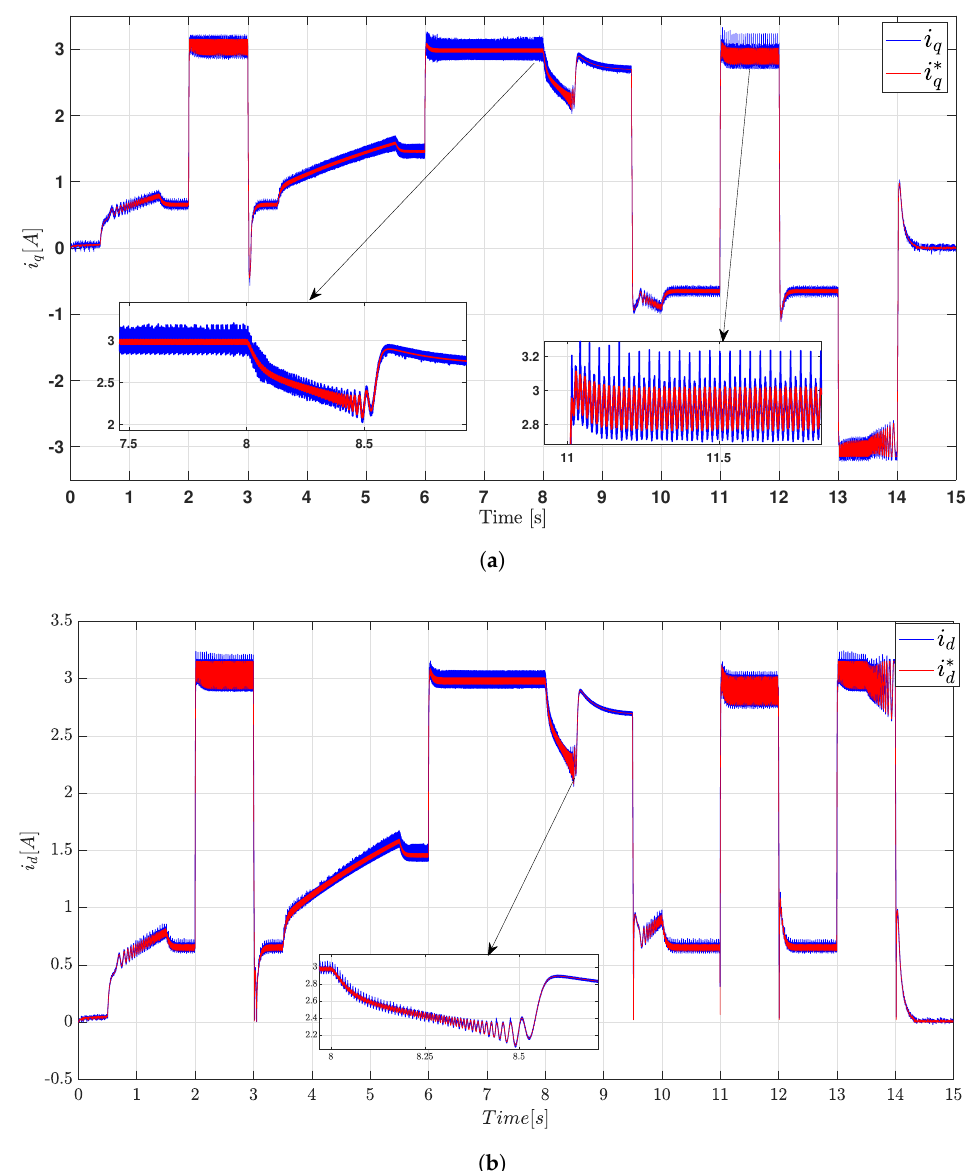
Figure 10. Response of the current components obtained by the PI controllers and the maximum torque per ampere method: ( a ) i q response and ( b ) i d